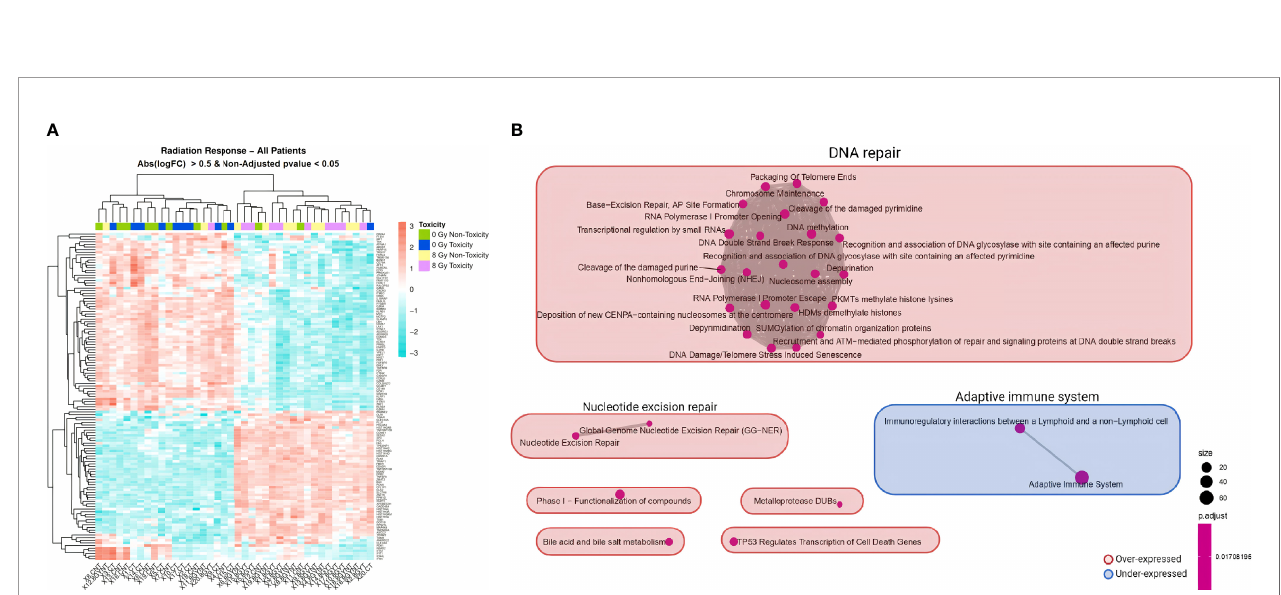
FIGURE 3 | Heatmap and GSEA of overall in-vitro radiation response comparing irradiated to non-irradiated samples in all patients. (A) A clear different expression pattern is observed between non-irradiated (non-toxicity in green and toxicity in dark blue) and 8 Gy-irradiated (non-toxicity in yellow and toxicity in pink) PBMC samples. Hierarchical clustering of the differentially expressed genes with non-adjusted p < 0.05 and absolute logFC >0.5 almost perfectly separates the two experimental conditions. (B) The enrichment map allows the visualization of the general expression landscape of the irradiated compared with the non-irradiated PBMCs. The key is shown in the bottom right of the fi gure. The map is constructed with an FDR cutoff of <0.05. Each node corresponds to a gene set from the GSEA; its size represents the number of genes in the gene set and its color the p -value. The thickness of the lines connecting the nodes is proportional to the number of genes that overlap in the gene set. Clustering among the various gene sets is visualized with boxes over the nodes. Those sets that are upregulated in irradiated samples are shown in red and those downregulated are shown in blue. Abs, absolute; CNT, control non-irradiated sample in non-toxicity patients; 8 Gy NT, 8 Gy-irradiated culture in non-toxicity patients; CT, control non-irradiated sample in toxicity patients; 8 Gy T, 8 Gy-irradiated culture in toxicity patients; PBMCs, peripheral blood mononuclear cells; GSEA, gene set enrichment